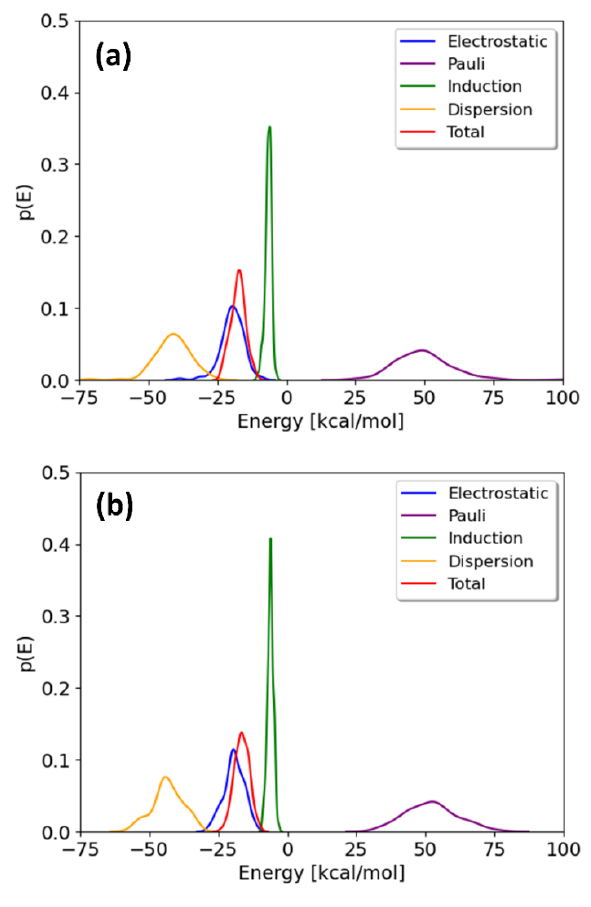
Figure 4. Distributions of the interaction energy and its different components on 100 geometries selected from the free energy minima of the TCDD ( a ) and TCDF ( b ) permeation.